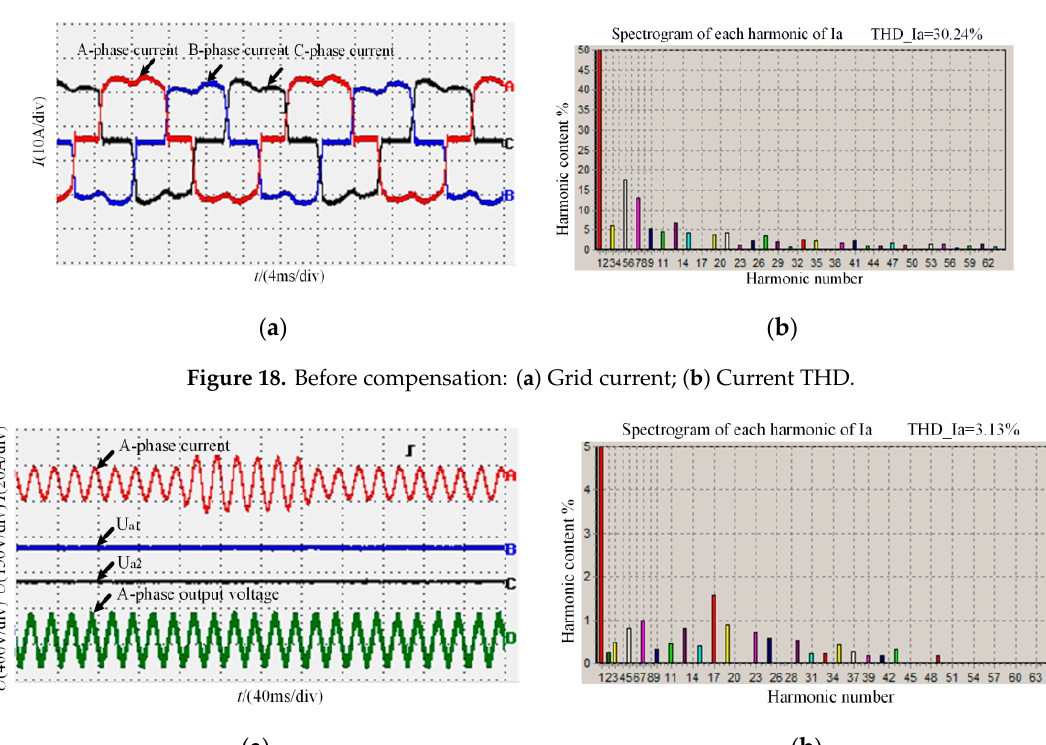
A-phase; ( b ) Current THD.